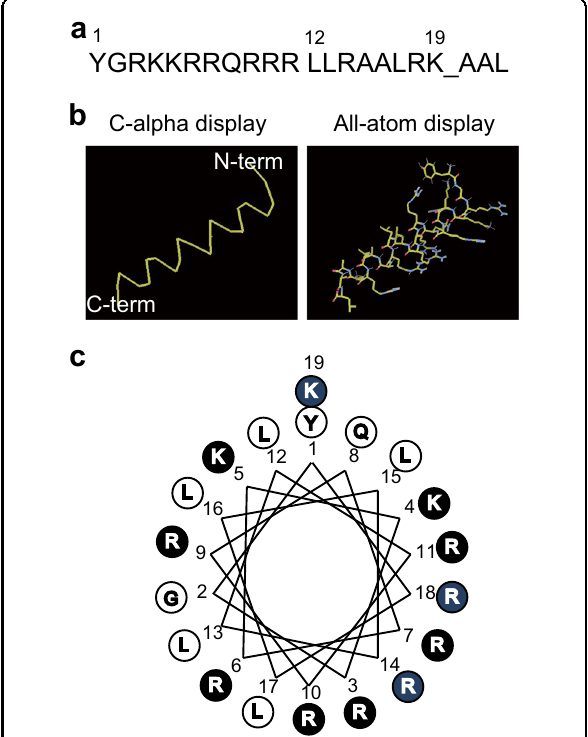
Fig. 1 Schematic structure of in silico-designed CAMP peptide. a Amino-acid sequence of the CAMP peptide. The cleavage site predicted by MitoProtII is marked with an underscore. b α -Helical structure of CAMP predicted by COOT. c Helical wheel projection of CAMP. Positively charged amino acids in TAT are presented in black, and those in the MTS are